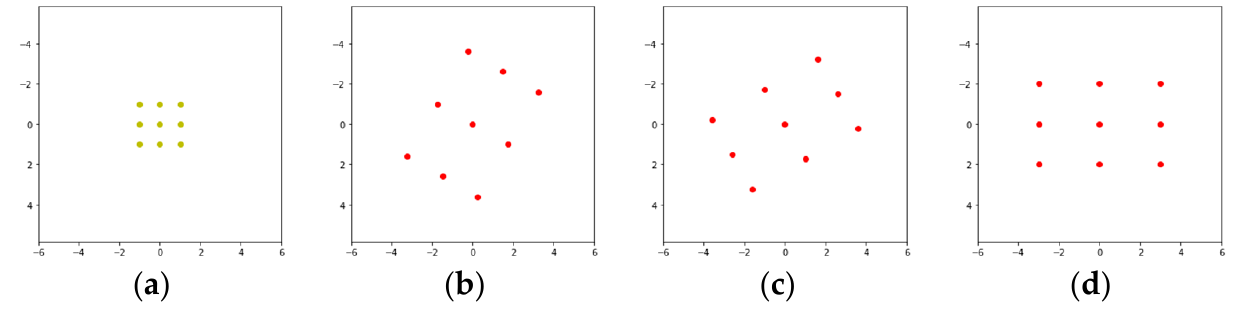
Figure 2. The sampling locations on a 3 × 3 kernel: ( a ) original sampling locations; ( b ) the sampling locations when ∆ w = 2, ∆ h = 3, and θ = 30 0 ; ( c ) the sampling locations when ∆ w = 2, ∆ h = 3, and θ = 60 0 ; ( d ) the sampling locations when ∆ w = 2, ∆ h = 3, and θ = 90 0